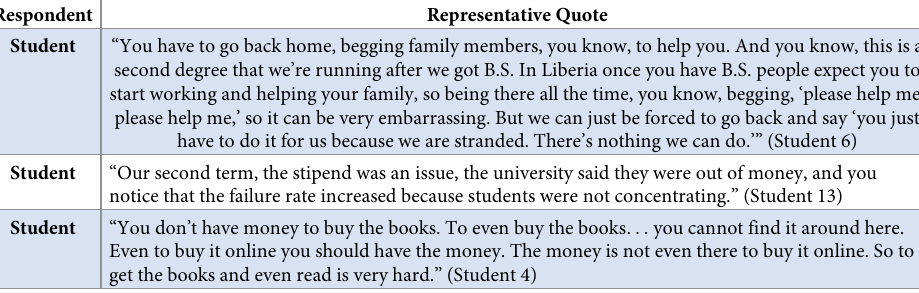
Table 5. AMD students’ financial challenges